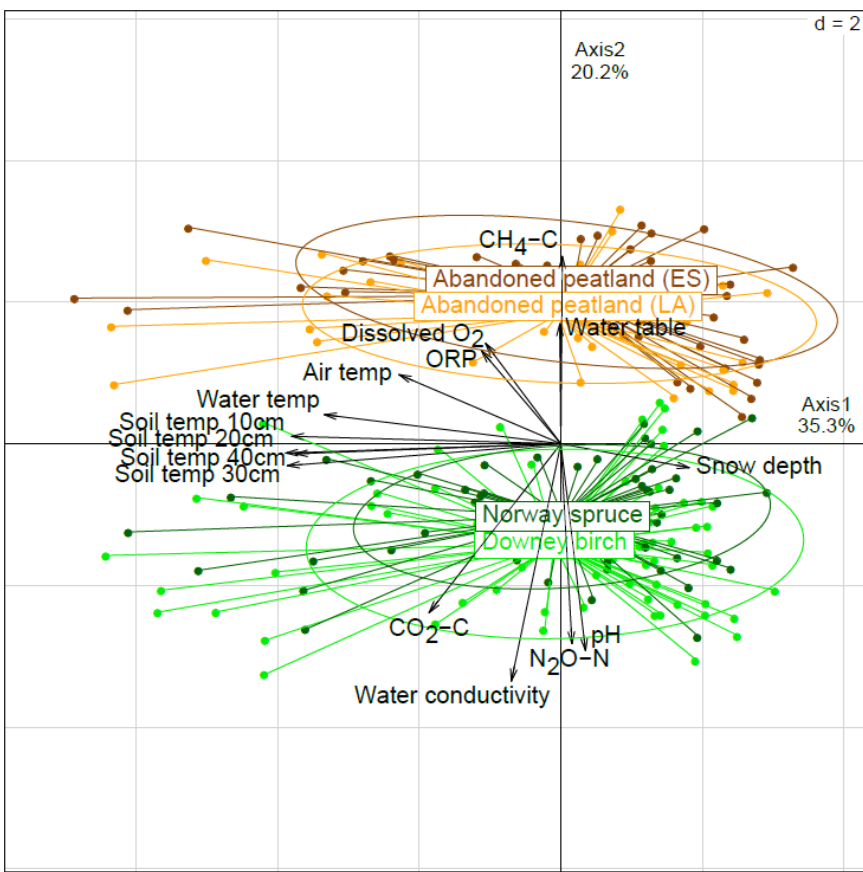
Figure 2. Principal component analysis (PCA) ordination plot with 95% confidence ellipses showing the grouping of studied sites according to environmental characteristics (n = 215). Abbreviations: temp—temperature, ORP—oxidation-reduction potential.